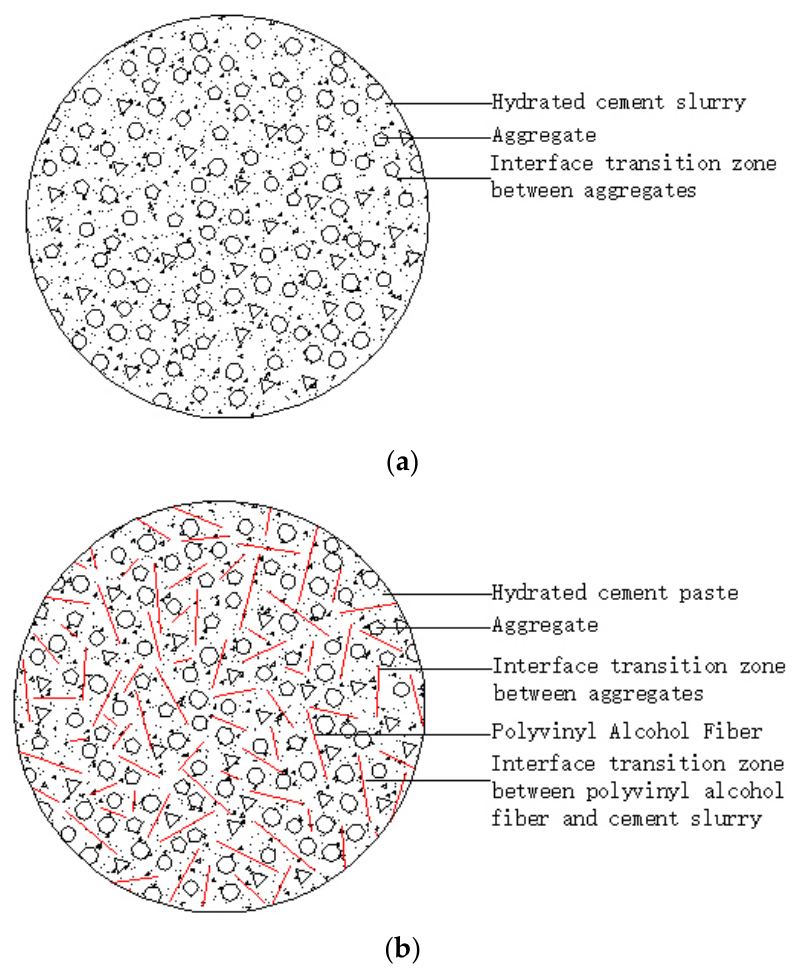
Figure 9. Concrete internal structure:( a ) Ordinary concrete, ( b ) Silica fume—polyvinyl alcohol fiber concrete.